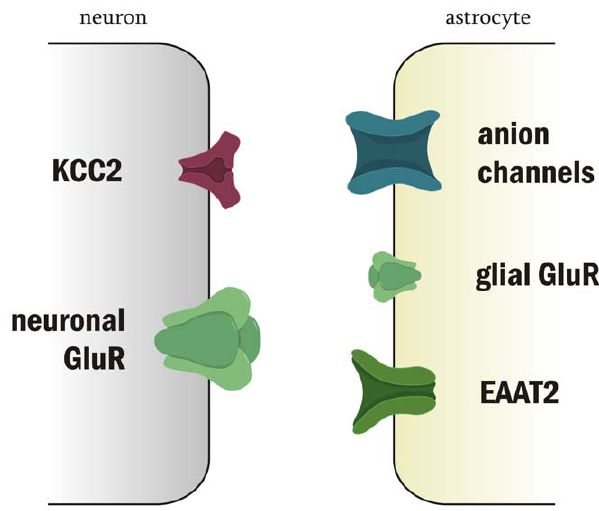
Figure 7. Molecular dissection of processes underlying spatio- temporal IOS generation. Neuronal (left) and glial (right) proteins underlying IOS mechanism are sized in accordance with their contribution to IOS genesis. Neurons are activated first after Schaffer collateral stimulation, followed by neuronal somatic swelling and subsequent swelling of glial